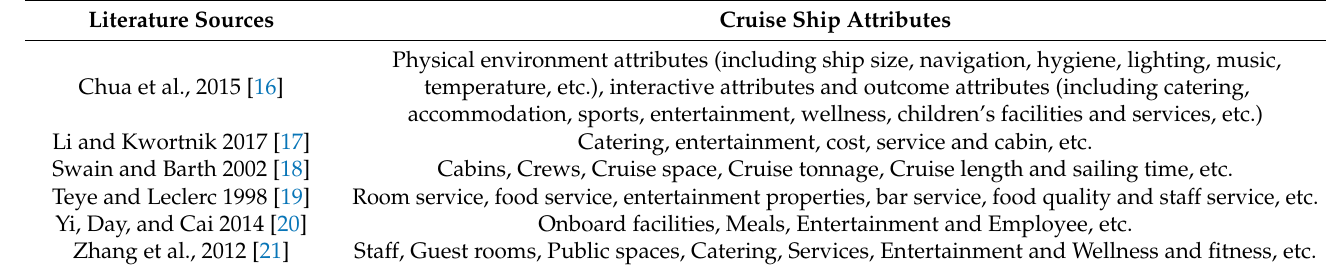
Table 1. Important cruise ship attributes and its literature